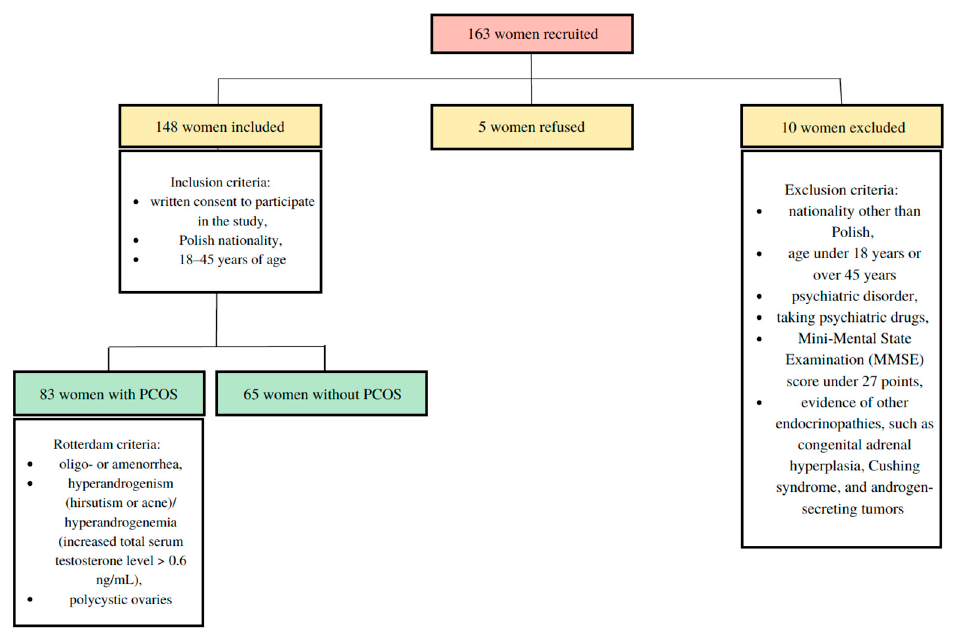
Figure 1. Patient-selection process.